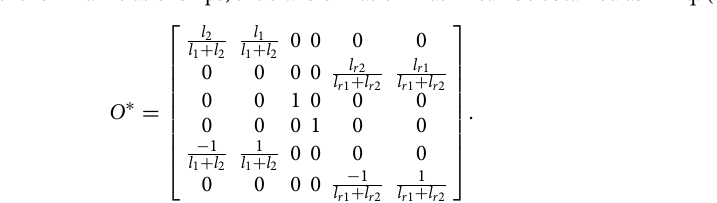
Using Eq. (9) and other similar relationships, the transformation matrix can be obtained as in Eq. (10).